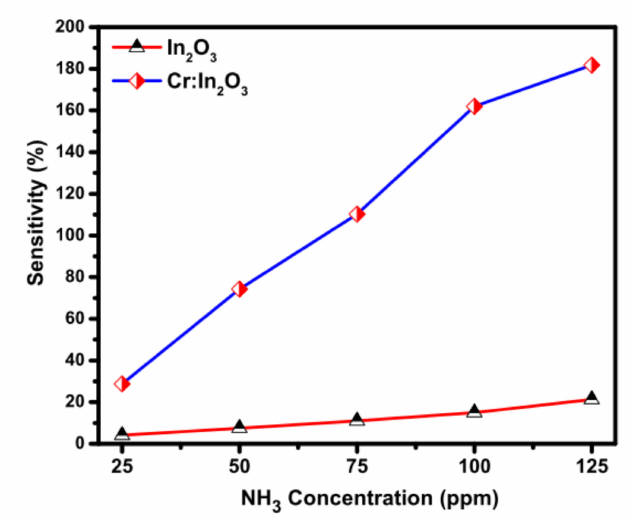
Figure 8. Variation of NH 3 sensitivity for pure In 2 O 3 and Cr doped In 2 O 3 thin films at different NH 3 concentrations.